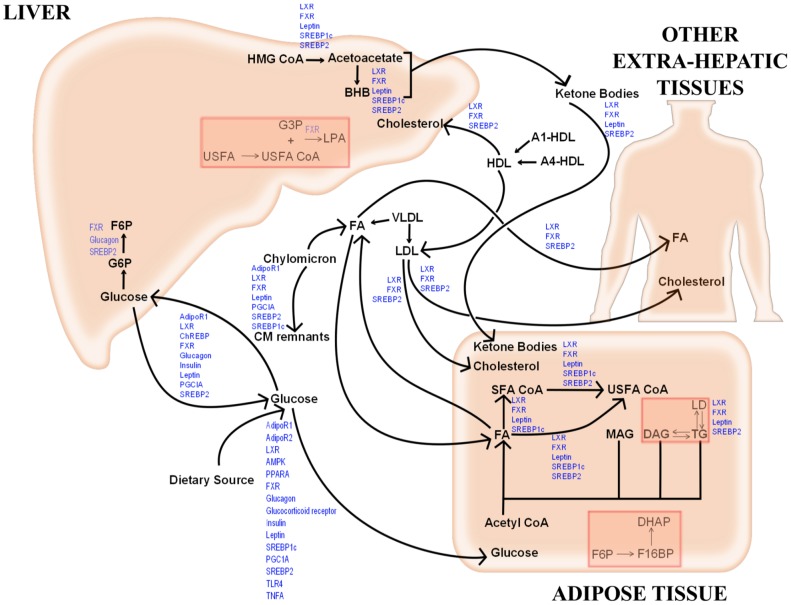
Hepatic triglyceride sensitivity network.The represented pathways highlight high impact branches that significantly influence hepatic triglyceride concentration. The branch-points in the red boxes indicate high impact branches with low tolerance to flux alterations. Pathway regulators (blue text) that are influenced by alterations in flux distribution are labelled at the corresponding high impact branch-points. AdipoR- Adiponectin Receptor, AMPK- Adenosine Monophosphate- activated Kinase, BHB- beta-Hydroxybutyrate, ChREBP- Carbohydrate Response Element Binding Protein, CM- Chylomicron, DAG- Diacylglycerol, DHAP- Dihydroxyacetone phosphate, FA- Fatty Acid pool, F6P- Fructose-6-phosphate, F16BP- Fructose-1,6-bisphosphate, FXR- Farnesoid×Receptor, G3P- Glycerol-3-Phosphate, G6P- Glucose-6-Phosphate, HDL- High Density Lipoprotein, HMG CoA- 3-Hydroxy 3-Methylglutaryl CoA, LD- Lipid Droplet, LDL- Low Density Lipoprotein, LPA- Lysophosphatidic Acid, LXR- Liver×Receptor, MAG- Monoacylglycerol, PGC1A- Peroxisome Proliferator- Activated Receptor Gamma Coactivator 1 alpha, PPARA/G- Peroxisome Proliferator- Activated Receptor Alpha/Gamma, SFA CoA- Saturated Fatty Acyl CoA, SREBP- Sterol Regulatory Element Binding Protein, TG- Triglyceride, TLR4- Toll-like Receptor 4, TNFA- Tumour Necrosis Factor Alpha, USFA CoA- Unsaturated Fatty Acyl CoA, VLDL- Very-Low Density Lipoprotein.